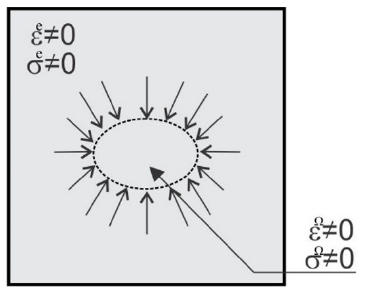
Figure 5: Eshelby's problem